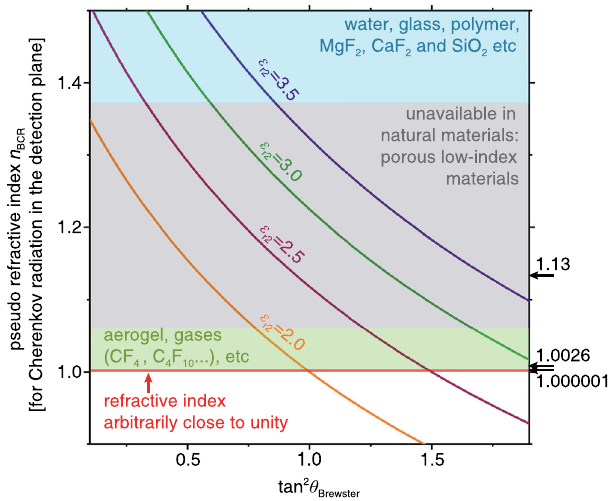
Fig. 3 Engineering the pseudo refractive index n BCR for Brewster- Cerenkov detectors, achieving parameter regimes that do not exist in natural materials. For the transmitted Cherenkov radiation in the detection plane, its wavevector component parallel to the detection plane has k